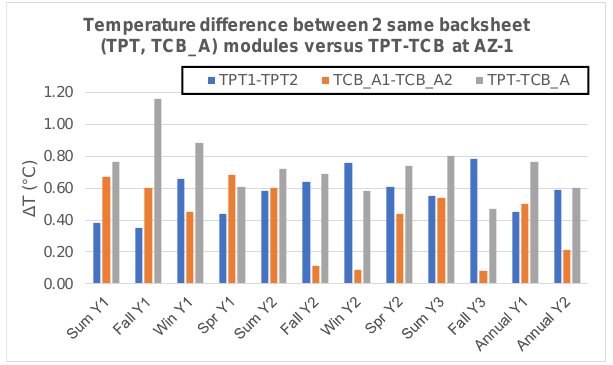
Figure 4. Comparison of cell temperature differences between modules of the same backsheet (TPT, TCB_A) versus TPT-TCB_A measured at the AZ-1 site.